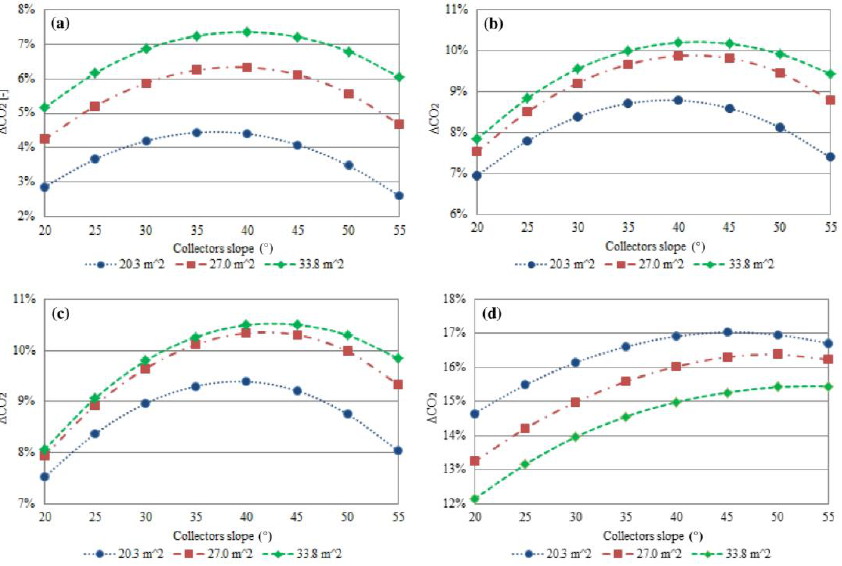
Figure 14. Equivalent CO 2 avoided emissions of the ASs with 0% of solar thermal energy surplus used and with flat-plate collectors in the four alternative configurations: ( a ) Scenario A; ( b ) Scenario B; ( c ) Scenario C; and ( d ) Scenario D.